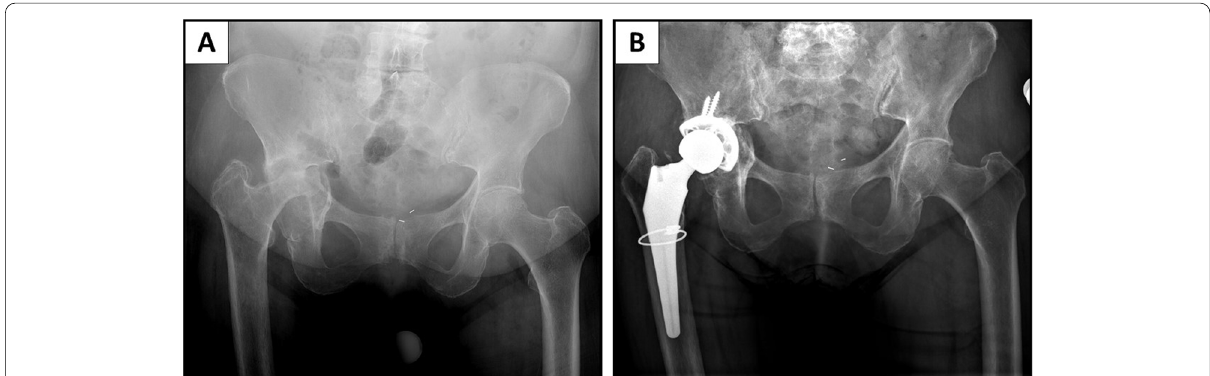
Fig. 2 Complex primary THA: A Preoperative pelvis AP radiograph of 82 y/o female with previous acetabular fracture and arthrosis. B Postoperative AP pelvis radiograph of fully porous cup with cemented XLPE liner and two locking screws